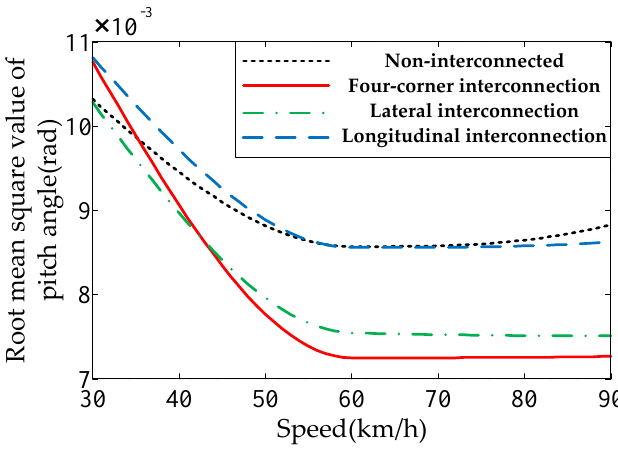
Figure 10. RMS value of roll angle under the steering condition.